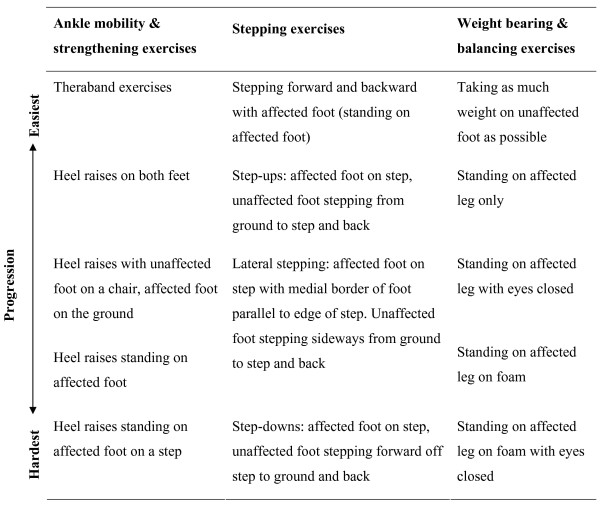
The home exercise programme. Participants will perform one exercise from each category of exercise. The physiotherapist will be responsible for the prescription, instruction, monitoring, and progression of the exercises.